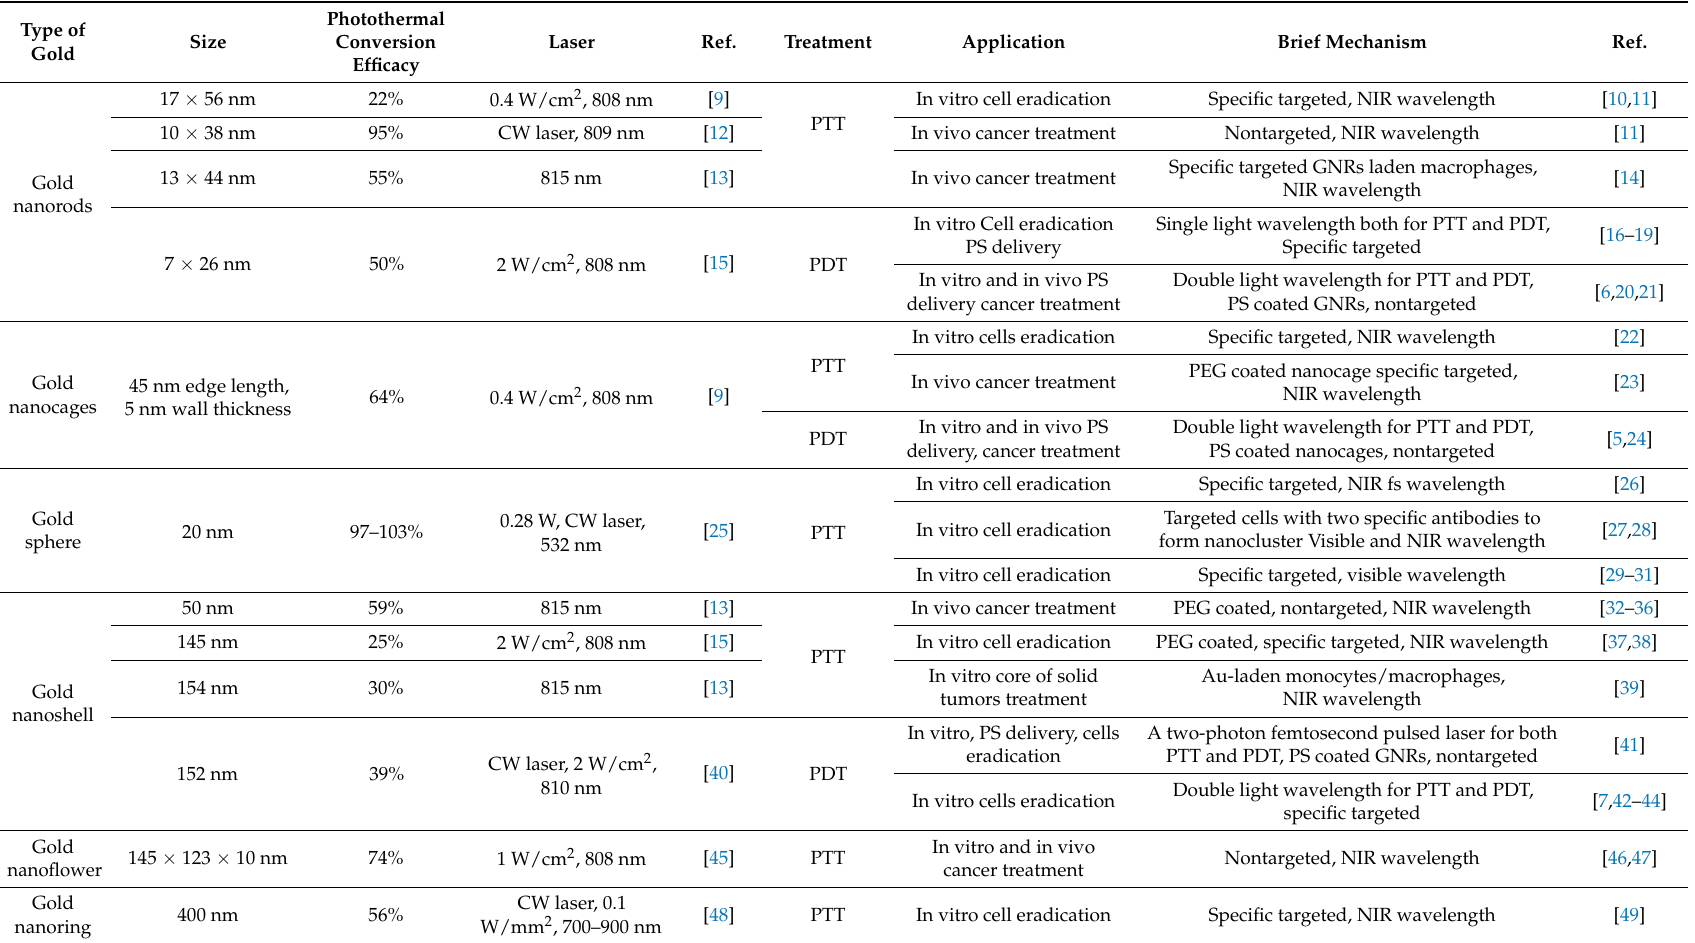
Table 1. The summary of photothermal conversion efficiencies of gold nanoparticles of various shapes and PTT or PDT